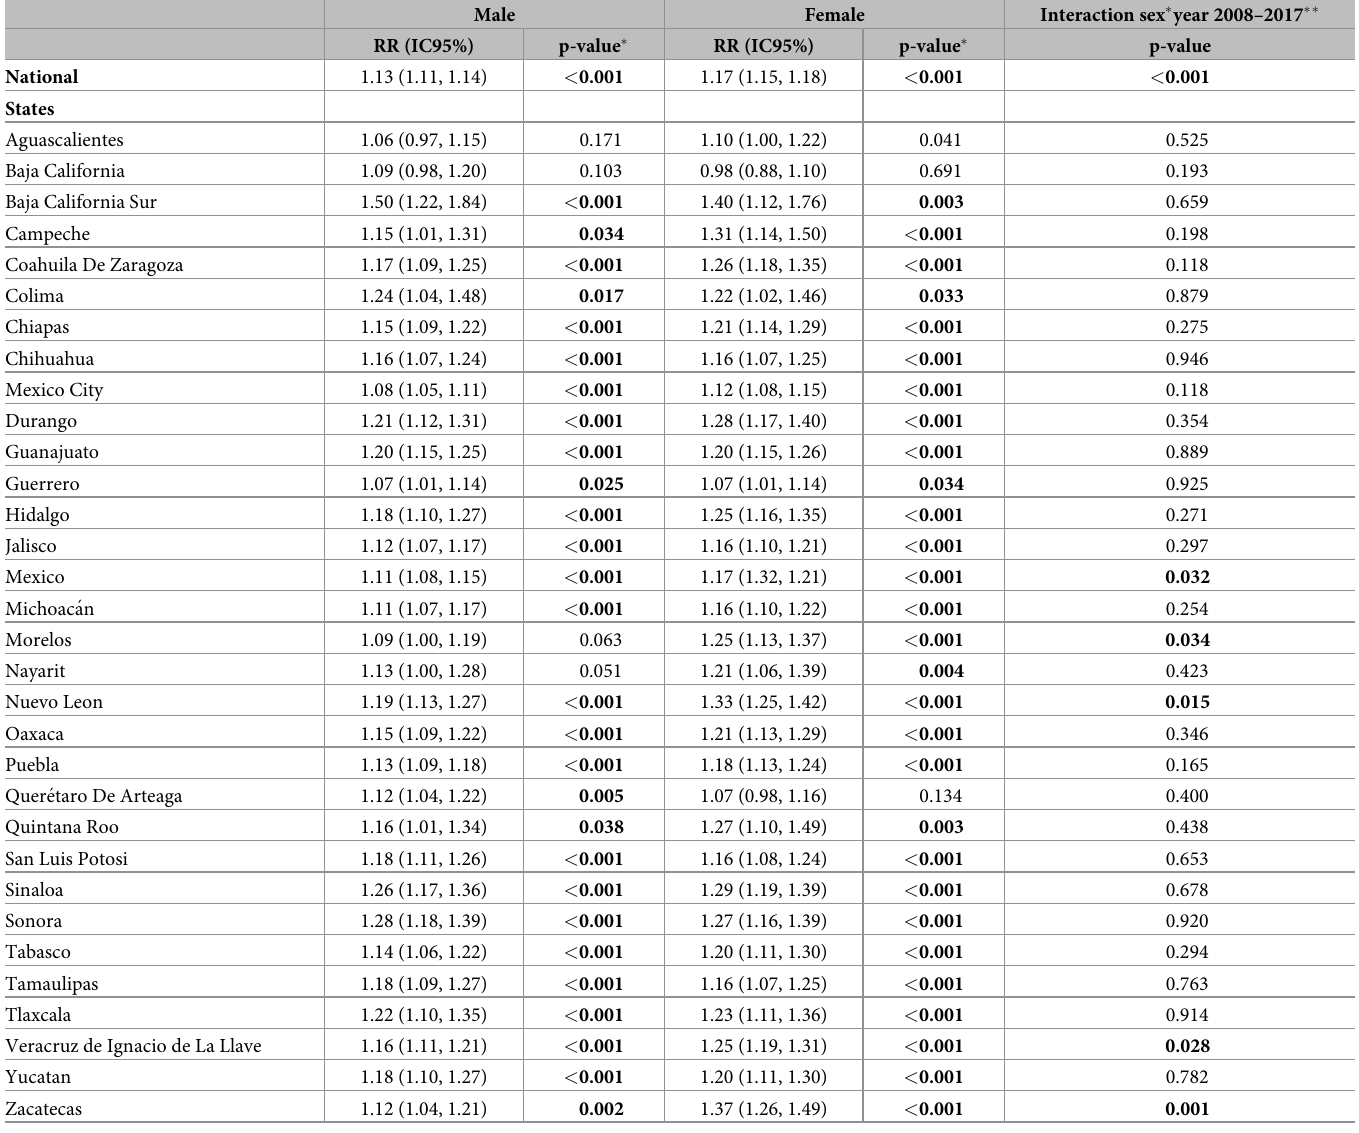
Table 1. Relative Risk (RR) and 95% confidence intervals (CI) of LBW per year of birthday and State, from 2008 to